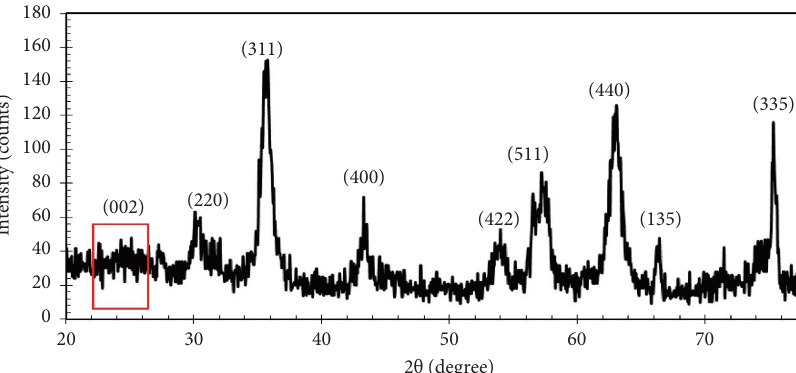
Figure 3: X-ray difraction pattern of surface-modifed carbon nanotubes by nanomagnetite.